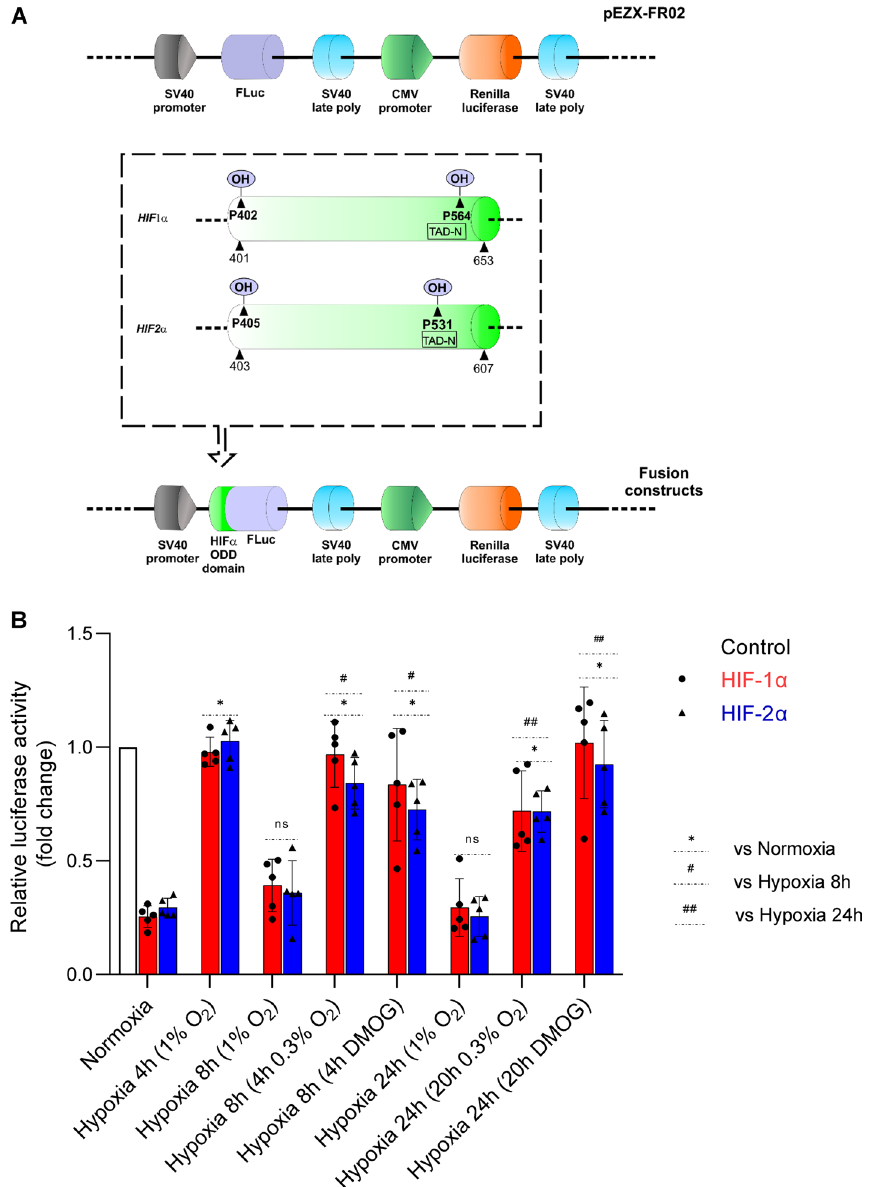
Fig. 4 Prolyl hydroxylase inactivation in HUVECs influences ODD domains stability during hypoxia. A Schematic presentation of firefly luciferase (FLuc) and renilla luciferase reporter cloning vector pEZX-FR02 (GeneCopoeia) containing the HIF1A human (NM_181054) gene region comprising ODD (amino acids 401–653, including the Prolines 402 and 564 (a PHD substrate) or human EPAS1 (NM_001430) gene region comprising ODD (amino acids 403–607, including the Prolines 404 and 531 (a PHD substrate). These gene regions were fused with firefly luciferase (without the ATG start codon) downstream of the HIF-α . B Hypoxia-related stabilization of the HIF-1α and HIF-2 α ODD reporter. HUVECs following the transfection with the HIF-α-ODD reporter vectors were exposed to hypoxia (1% O 2 ) for indicated time points in the presence or absence of 2.5 mM DMOG, or exposed to 0.3% O 2 (both DMOG addition and the exposure to 0.3% O 2 were performed after 4 h form the experiments start) and luciferase activity measured with Dual-Luciferase Reporter Assay System. The locations of the proline hydroxyl addition that destabilizes the HIF alpha subunits is illustrated in the panel A box. The firefly luciferase data were normalized to Renilla signal and expressed as a fold change over the control vector (without HIF-α-ODD) in the same experimental conditions. R.L.U. – relative light units. Data represent the mean SD of five independent experiments (3 replicates each). The ± P < 0.05 was considered significant and depicted as follows: * (for pairwise comparison to normoxia), # (for pairwise comparison to hypoxia 8 h), ## (for pairwise comparison to hypoxia 24